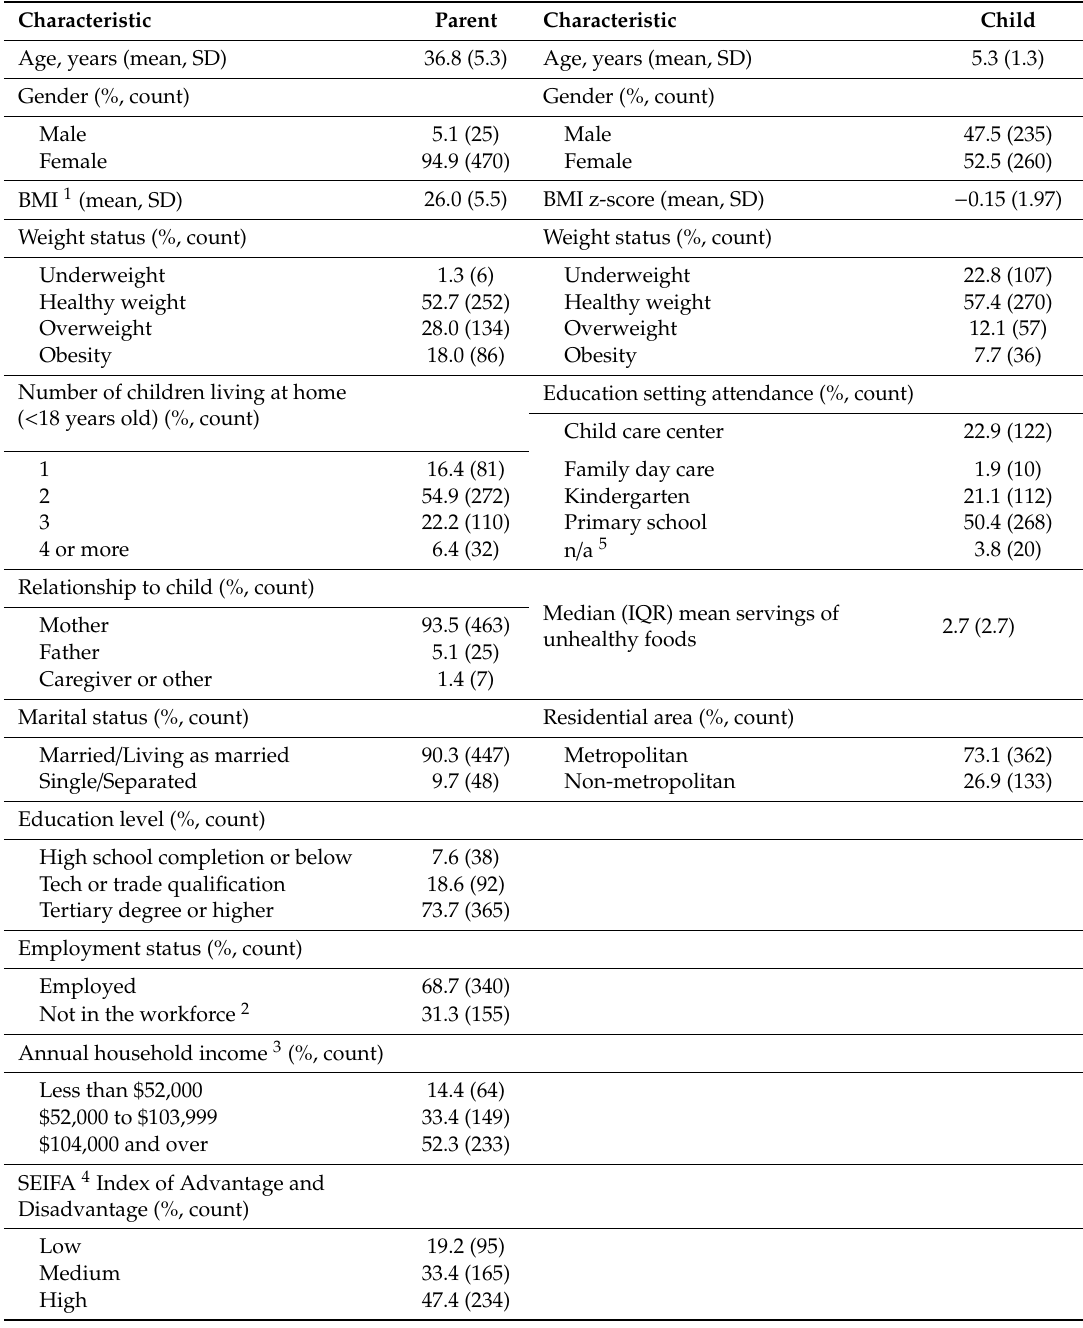
Table 1. Descriptive characteristics of parents and children sampled ( n =